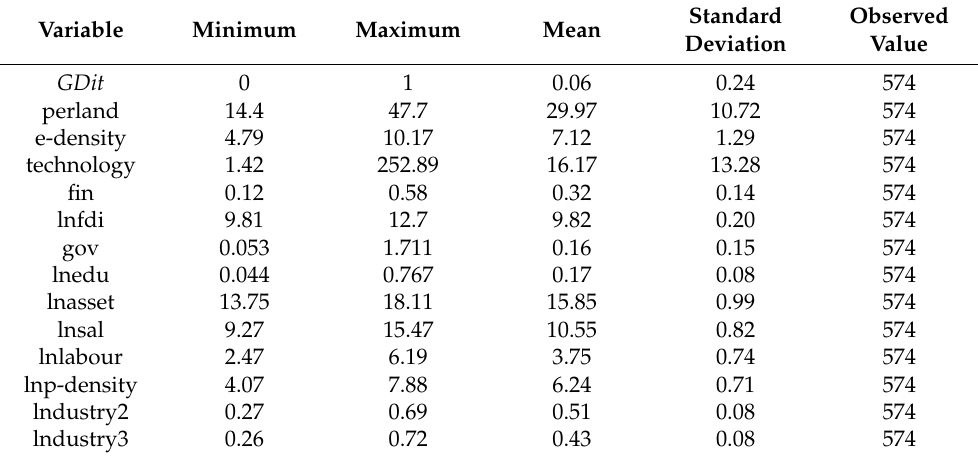
Table 2. Descriptive statistics of model